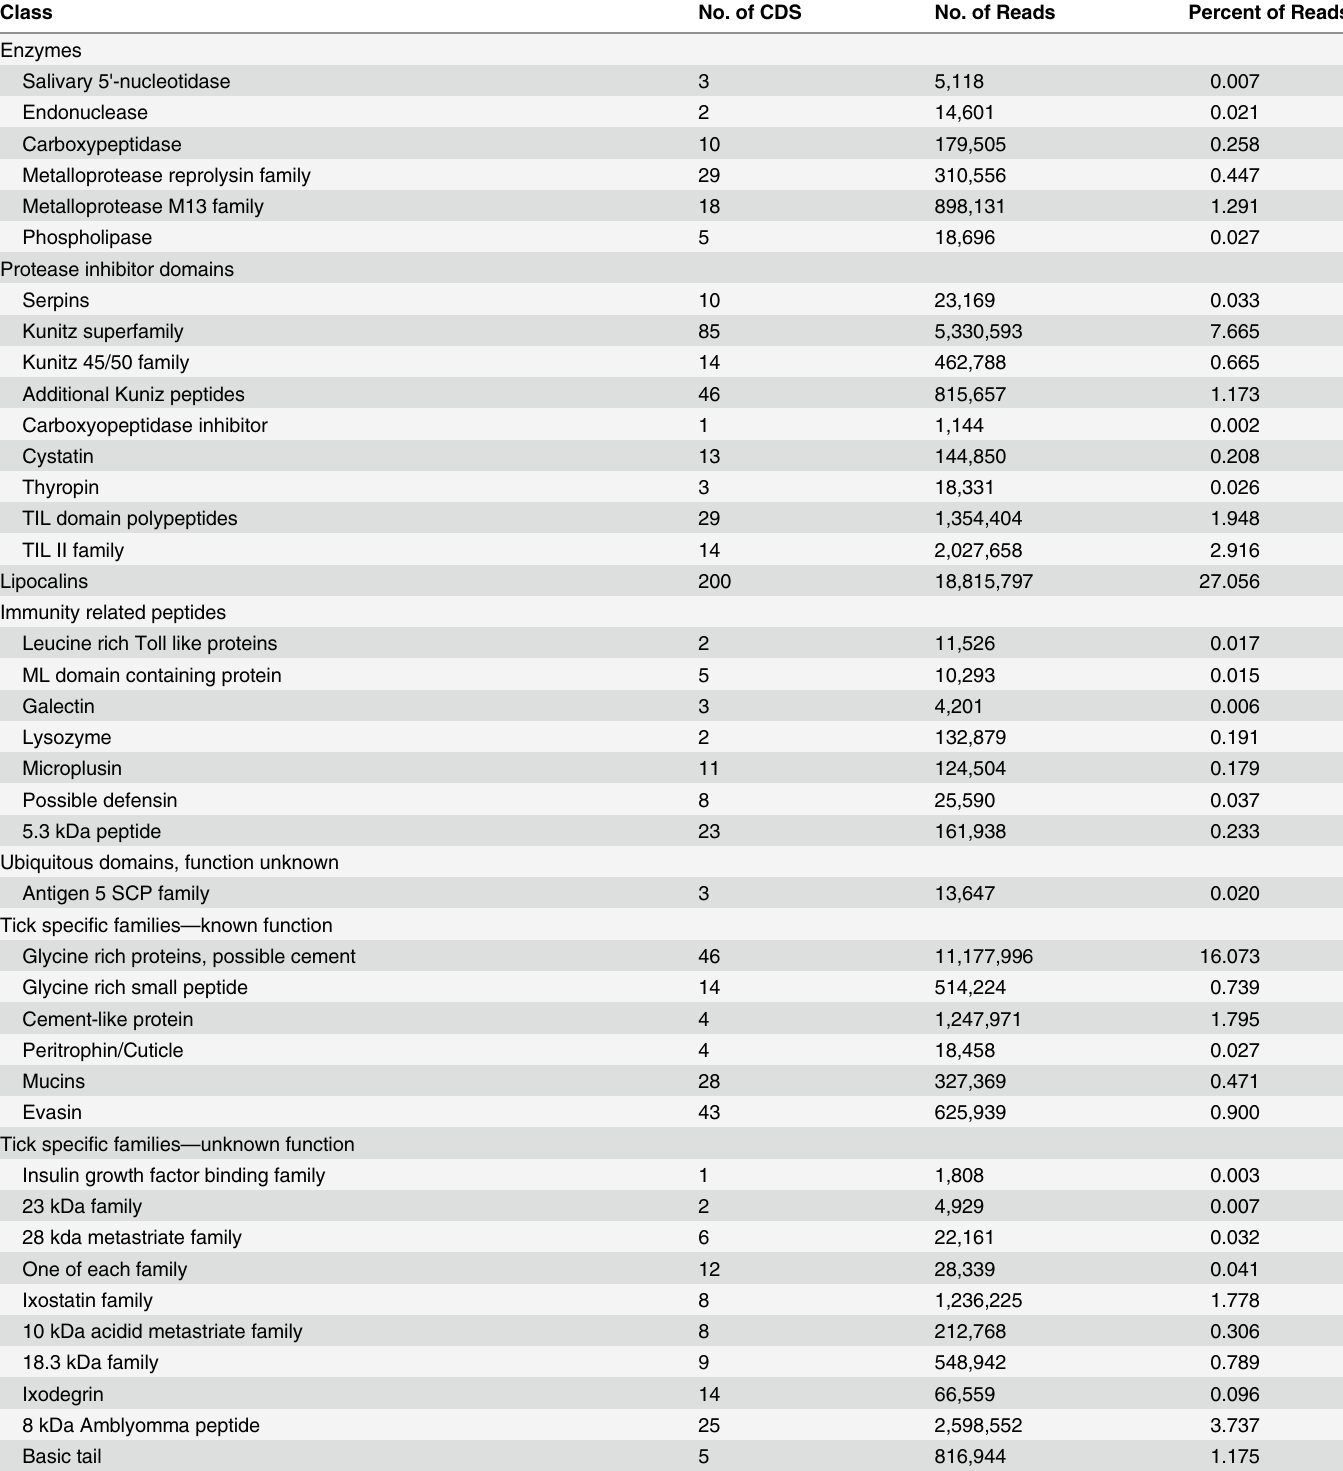
Table 2. Functional classification and associated mapped reads deriving from the CDS associated with putative secreted proteins found in the sia- lotranscriptome of Amblyomma americanum .